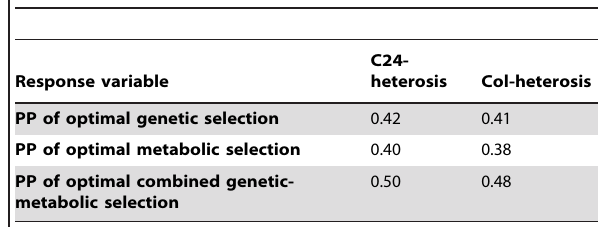
Table 1. Predictive power (PP) in leave-one-out validation of the respectively optimal selections of predictors for the relative mid-parent heterosis regarding the two different testcross